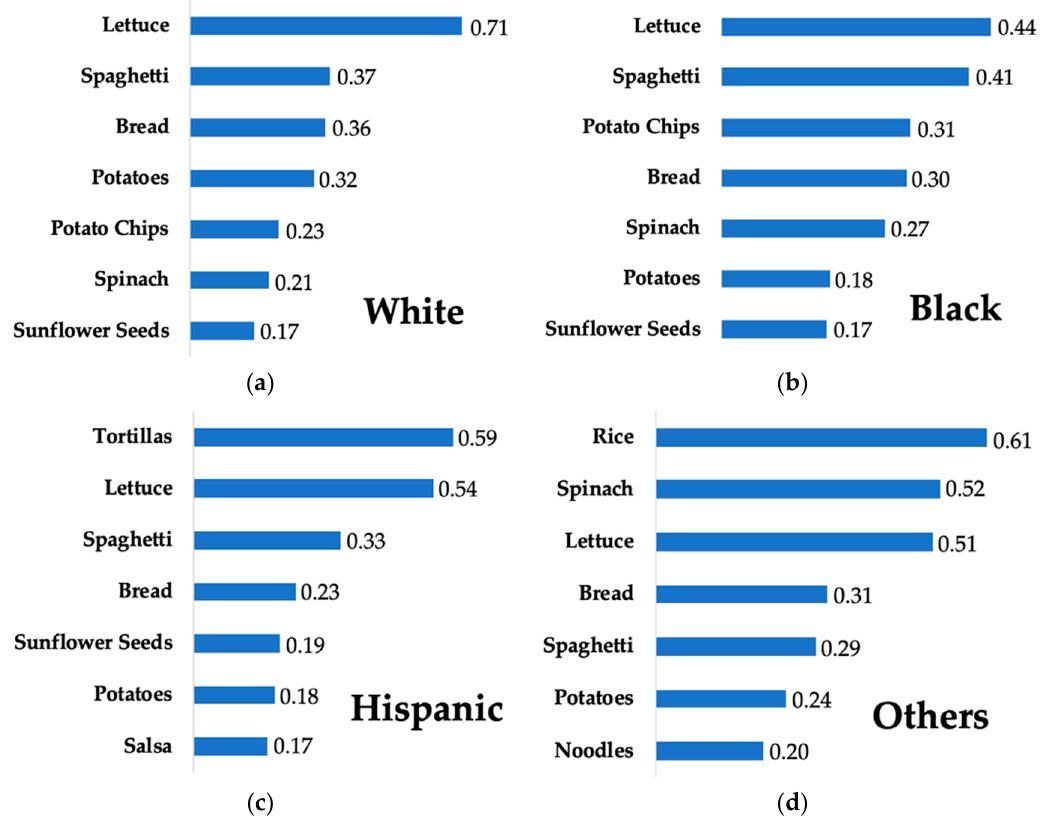
Figure 2. Cd contribution ( μ g/day/person) of top sources of dietary Cd intake among racial/ethnic groups in the US population aged ≥ 2 years in NHANES 2007–2012: ( a ) White; ( b ) Black; ( c ) Hispanic; ( d ) others including Asians.